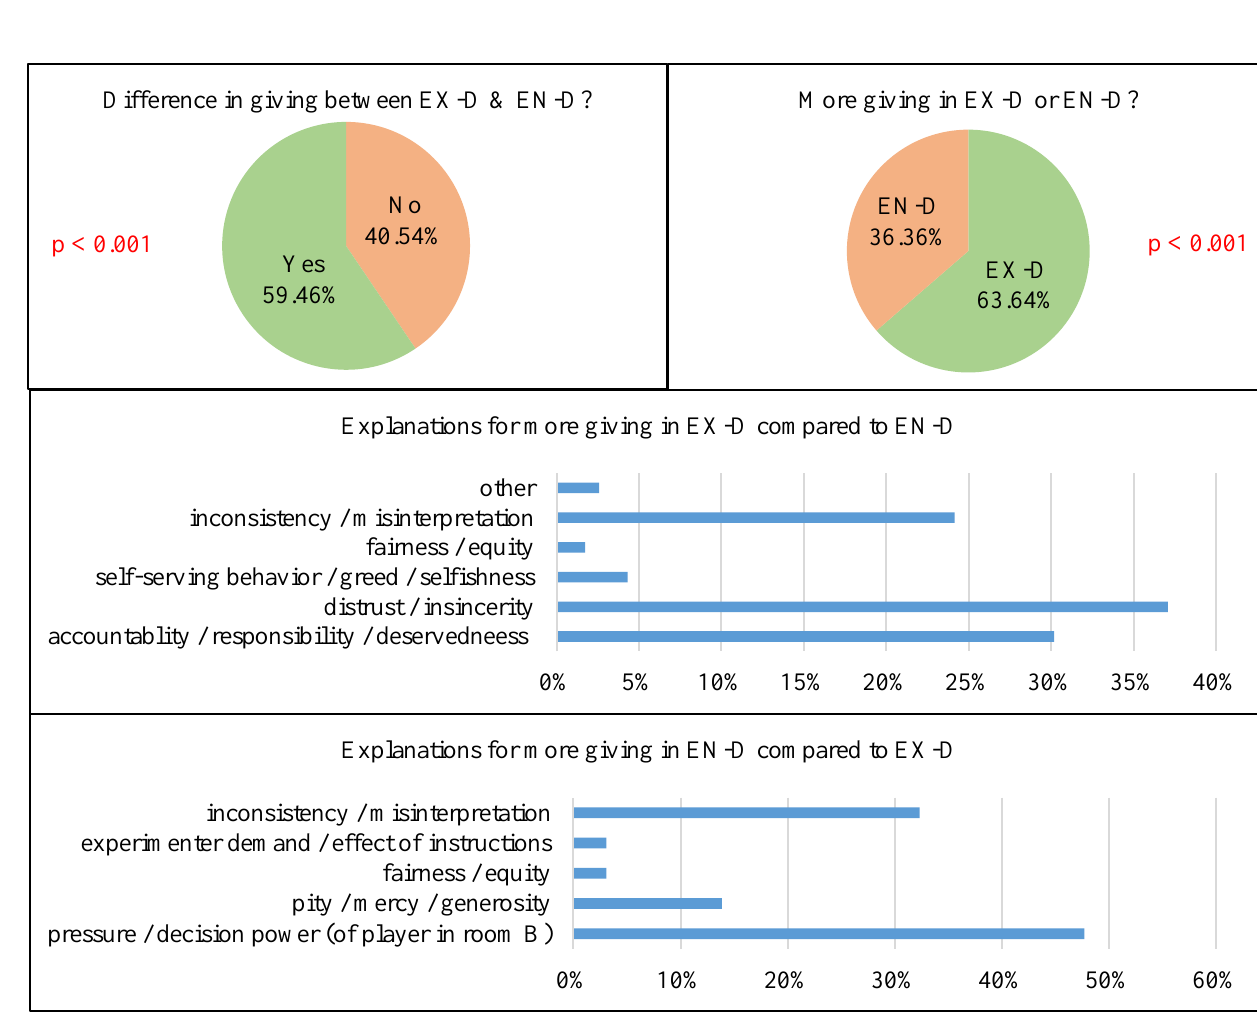
Figure 6. Survey results for Hypothesis 3 .